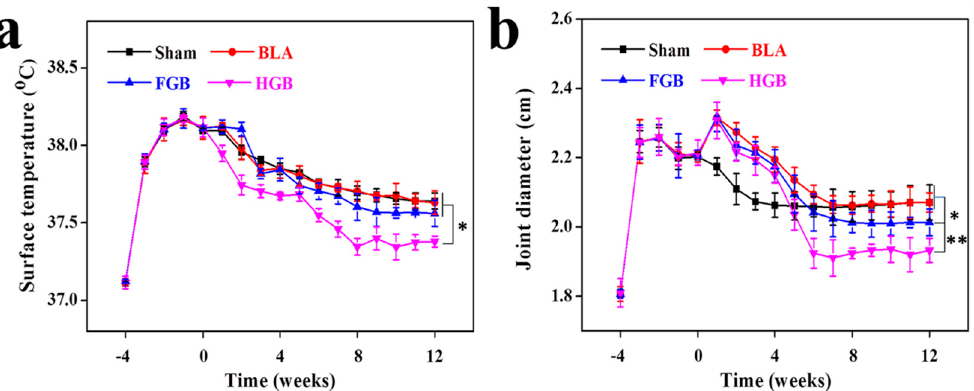
Figure 4. Measurements of ( a ) surface temperature and ( b ) joint diameter of left knee after induction of arthritis. The results are representative of means ± SD ( n = 5; * p < 0.05, ** p < 0.01).